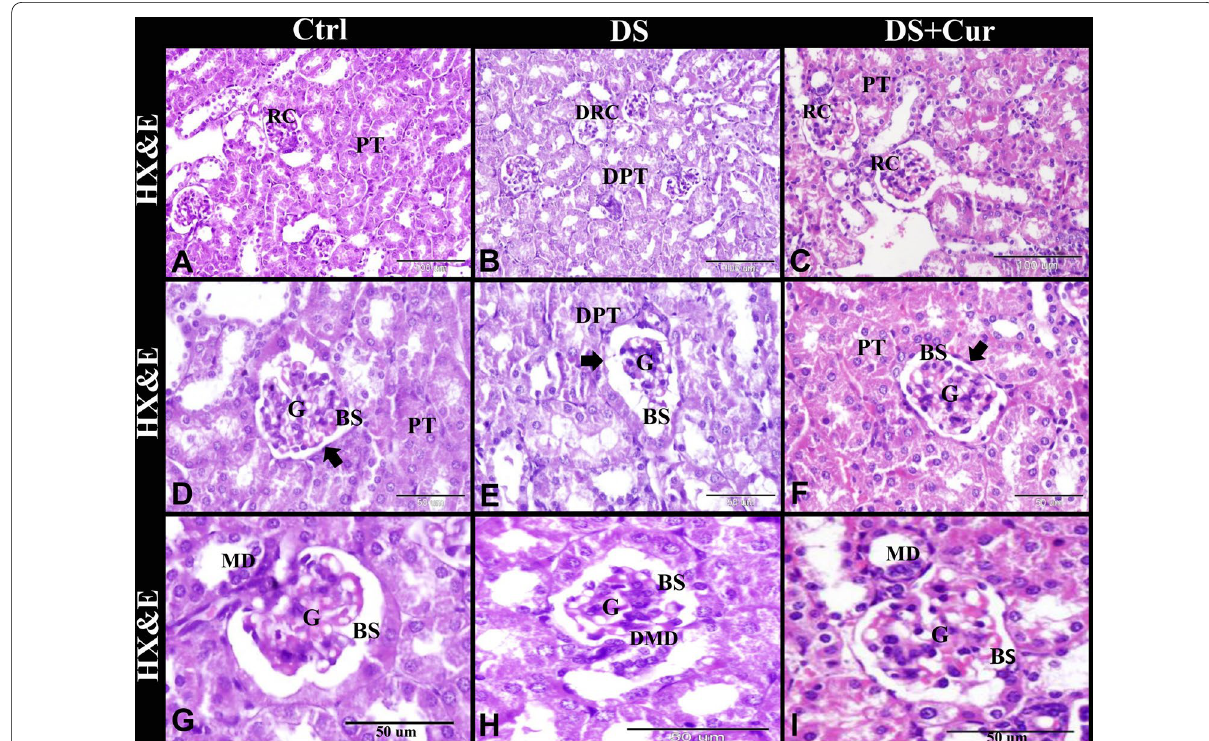
Fig. 2 Photomicrographs of paraffin sections stained with Hematoxylin and Eosin (HX&E) illustrated the protective effect of curcumin on diclofenac sodium induced renal damage in rat. A The kidney of control (Ctrl) group showed normal architecture of renal corpuscles (RC) and proximal tubules (PT). B The kidney of diclofenac sodium (DS) group showed degenerated renal corpuscles (DRC) and degenerated proximal tubules (DPC). C The kidney of diclofenac sodium curcumin (DS Cur) group showed restoration of the normal architecture of renal corpuscles (RC) and proximal + + tubules (PC). D The kidney of Ctrl group showed normal‑sized glomerulus (G) and Bowman’s space (BS), along with continuous healthy parietal layer of Bowman’s capsule (arrow) and normal proximal tubules (PT). E The kidney of DS group showed small‑sized glomerulus (G), wide Bowman’s space (BS), destructed parietal layer of Bowman’s capsule (arrow) and degenerated proximal tubules (DPC). F The kidney of DS Cur group showed + the restoration of the normal size of the glomerulus (G) and Bowman’s space (BS), along with continuous healthy parietal layer of Bowman’s capsule (arrow) and normal proximal tubules (PT). G The kidney of Ctrl group showed normal‑sized glomerulus (G) and Bowman’s space (BS) and normal macula densa cells of juxtaglomerular apparatus (MD). H The kidney of DS group showed small‑sized glomerulus (G), wide Bowman’s space (BS) and detached macula densa cells of juxtaglomerular apparatus (DMD). I The kidney of DS Cur group showed restoration of the normal size of + the glomerulus (G) and Bowman’s space (BS) and normal macula densa cells of juxtaglomerular apparatus (MD). Original magnification (A–C) X200, scale bar 100 μm, (D–I) X400, scale bar 50 = =